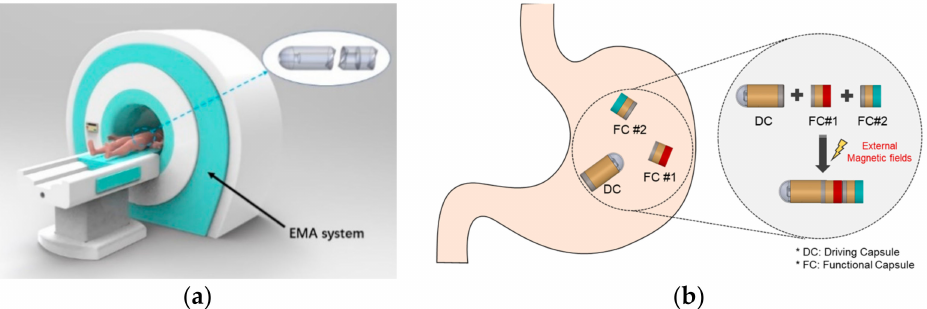
Figure 1. ( a ) Overview of the proposed modular capsule system [13]. ( b ) Recombination mechanism of the modular capsules.